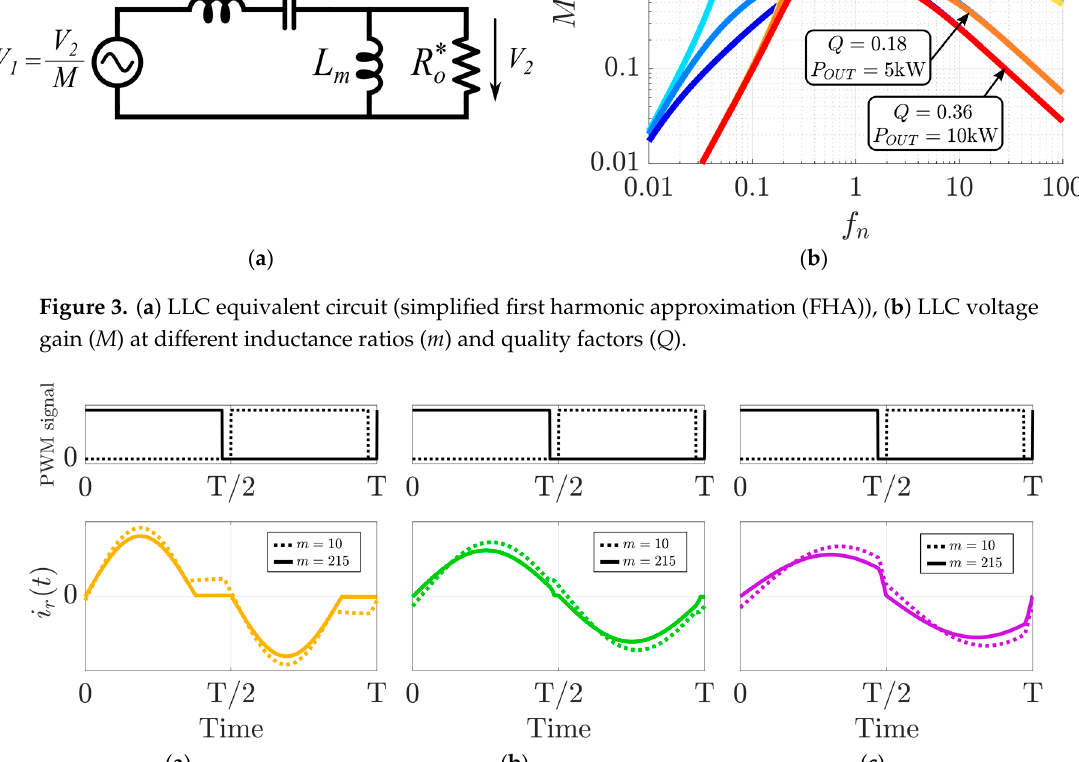
Figure 3. ( a ) LLC equivalent circuit (simplified first harmonic approximation (FHA)), ( b ) LLC voltage gain ( 𝑀 ) at different inductance ratios ( 𝑚 ) and quality factors ( 𝑄 ).